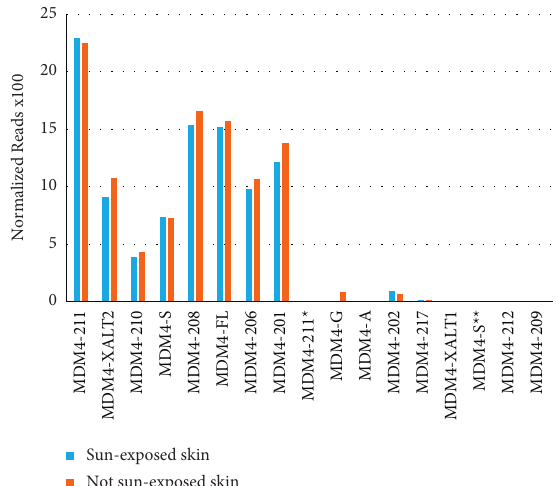
Figure 4: MDM4 isoform expression in normal skin. Non-sun-exposed (suprapubic) skin specimen data from 604 subjects and sun- exposed (lower leg) skin specimens from 701 subjects were analyzed in the GTEx data portal. Normalized reads × 100 for each indicated isoform of MDM4 are displayed ( y -axis). Isoforms are labeled using their common names or Ensembl numbers. Ensembl transcript evidence level 1 (TSL1) transcripts are in bold. ∗ This Ensembl transcript (ENST00000470908.5) shares a name with the transcript commonly called MDM4-211 (ENST00000367183.7). ∗∗ Two transcripts encode analysis, only 6.4% had at least 80% of their MDM4 reads skipping exon 9. However, these subjects had signifi- using the psichomics package in R (Figure 6). Skipping of cantly lower survival ( p � 0 . 00472). exon 9 indicates MDM4-A. Of 345 subjects in the